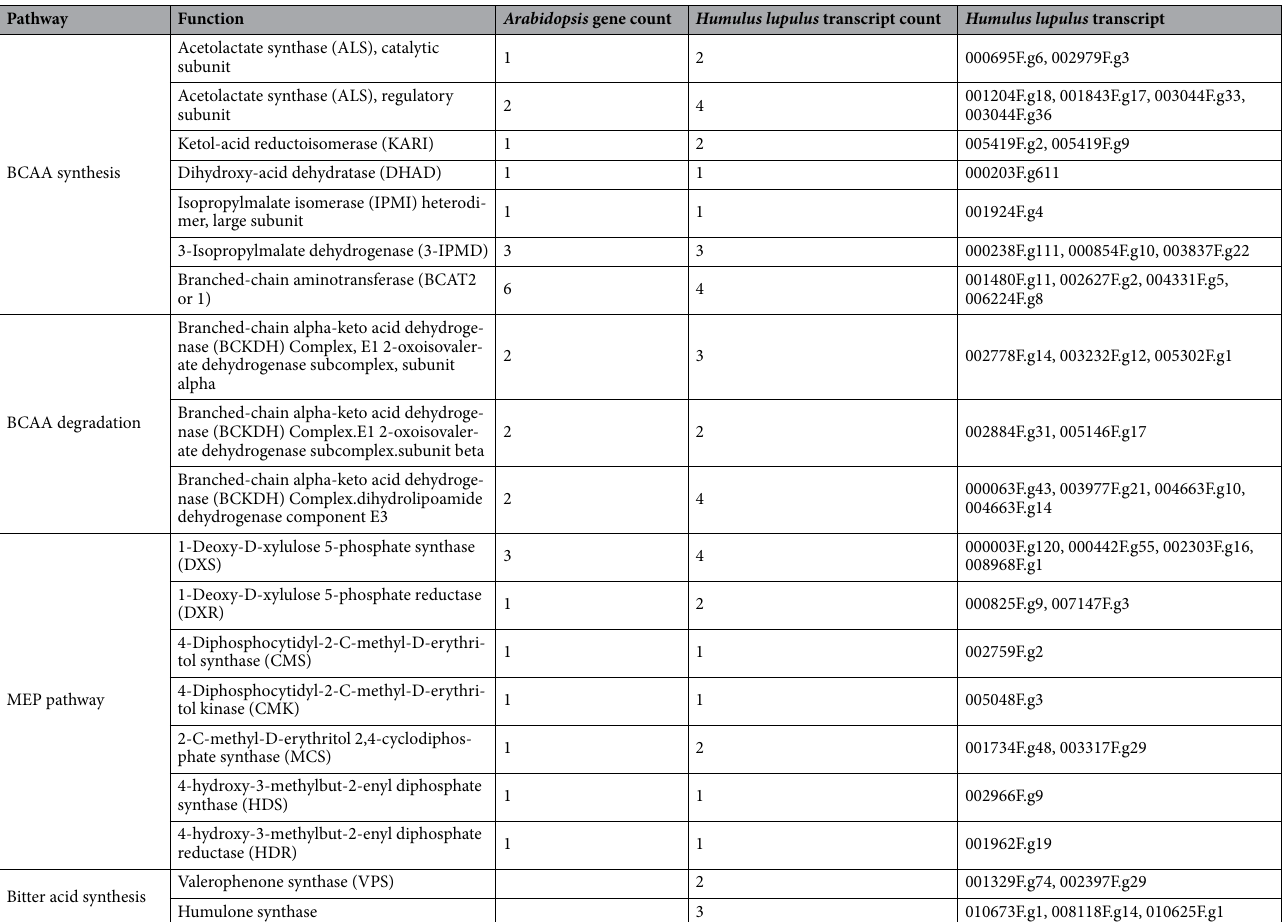
Table 1. A list of the pathways and genes involved in bitter acid (alpha and beta acids) production. The number of Arabidopsis thaliana genes is given according to Mercator4 annotations, and the number and transcript identifiers from H. lupulus cv. Cascade that are also according to Mercator4. Transcripts with low read counts (< 10) in leaf tissue were